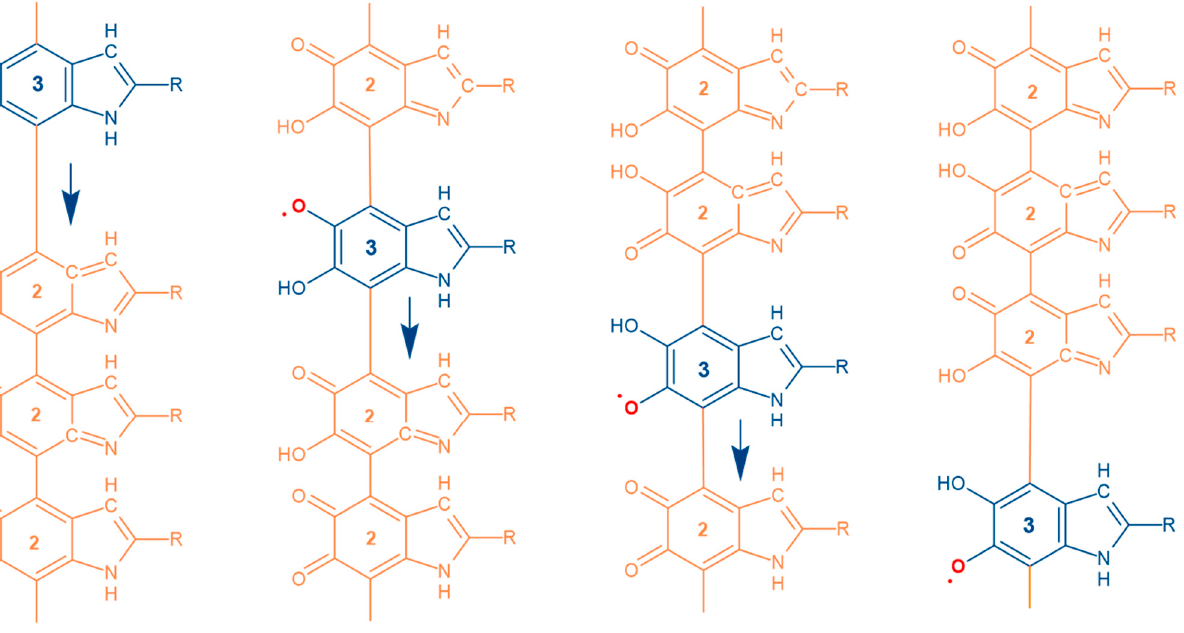
Figure 9. Semiquinone migration is shown as a blue monomer within orange oxidized monomers. The numbers correspond to the number of hydrogens within an indolequinone moiety. Blue arrows indicate the direction of movement of the semiquinone along the chain. The migration of semiquinone along the polyconjugated monomer chain can be represented as a concerted proton–electron transfer (CPET) [87]. In this case, the mobility of protons is strictly connected to the mobility of electron radicals within the chain.